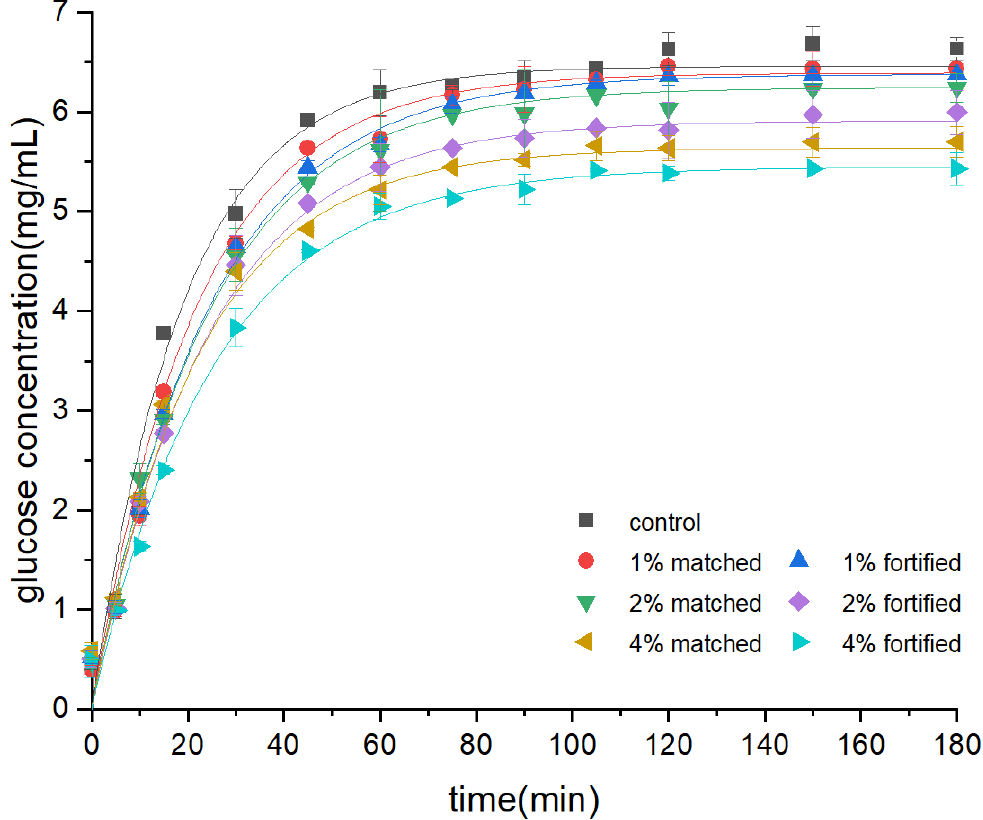
Figure 2. The concentration of reducing sugar released over time for in vitro digestion kinetics of 0, 1, 2, and 4% EGCG fortified bread and matched bread (control bread mixed with EGCG equivalent to fortified bread) and the corresponding fitting curves.